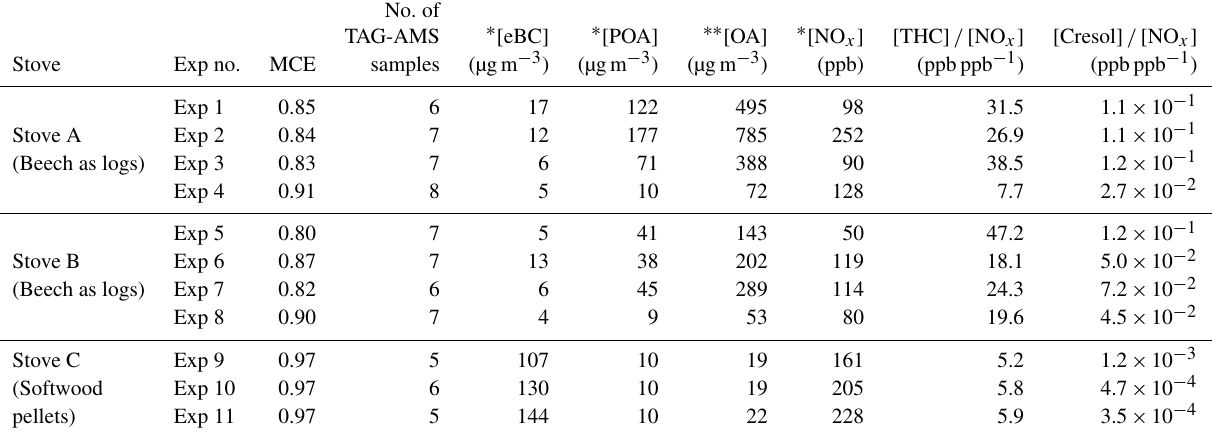
Table 1. Summary of the experiments and conditions in the chamber before lights-on (after a homogenization and stabilization period). MCE stands for modified combustion efficiency and THC is total hydrocarbon.